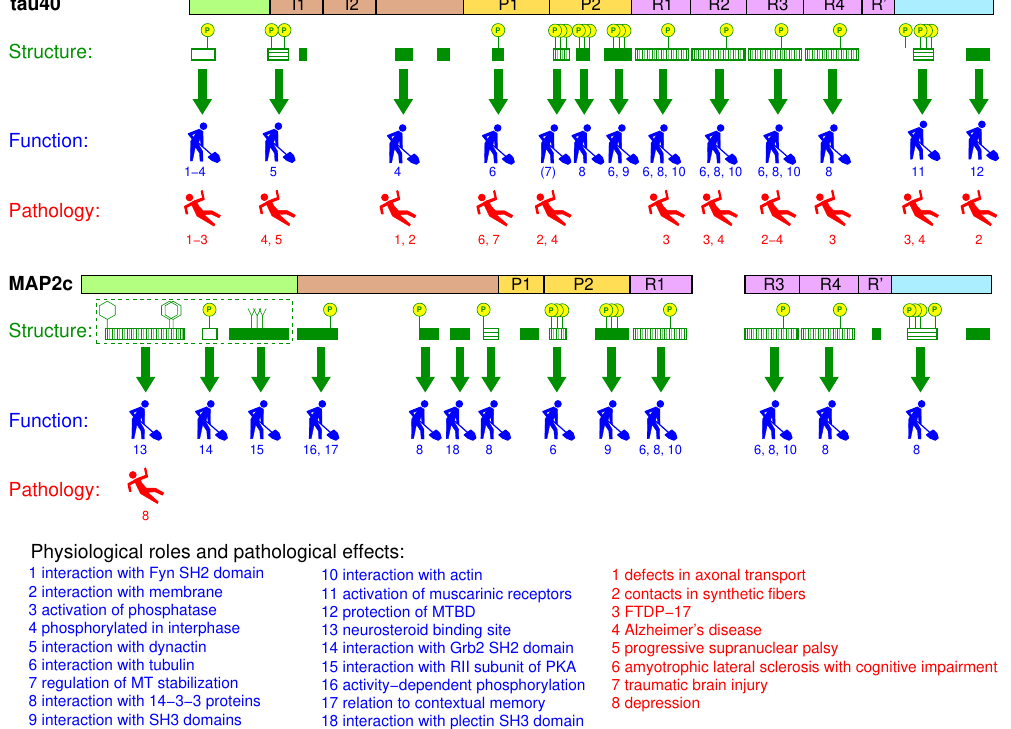
Figure 8. Association of biological functions with the transient structures of tau40 and MAP2c. Schematic representations of structural features (green symbols), normal physiological functions (blue symbols), and pathological effects (red symbols) are placed below horizontal bars showing regions of tau40 and MAP2c, colored as in Figure 2. The filled green rectangles represent all structural motifs with high population of transient secondary structures (continuous stretches of four residues found in polyproline II or α -helical conformation in more than 15% or 5%, respectively, structures in the ensemble selected by the ASTEROIDS analysis based on the experimental data), horizontal hatched green rectangles represent motifs associated with biological functions but with less populated secondary structures, vertical hatched green rectangles represent more complex motifs containing transient turn structures, and open green rectangles represent motifs not exhibiting significant secondary structure propensities but involved in long-range intramolecular interactions. The hexagons, Y-shapes, and circles with “P” above the rectangles indicate functionally important aromatic residues, hydrophobic aliphatic residues, and phosphorylation sites. The transient N-terminal compact structure of MAP2c is marked by the dashed frame. The thick green arrows show which structural motifs are associated with biological functions discussed in this paper, labeled by numbers explained under the diagrams.